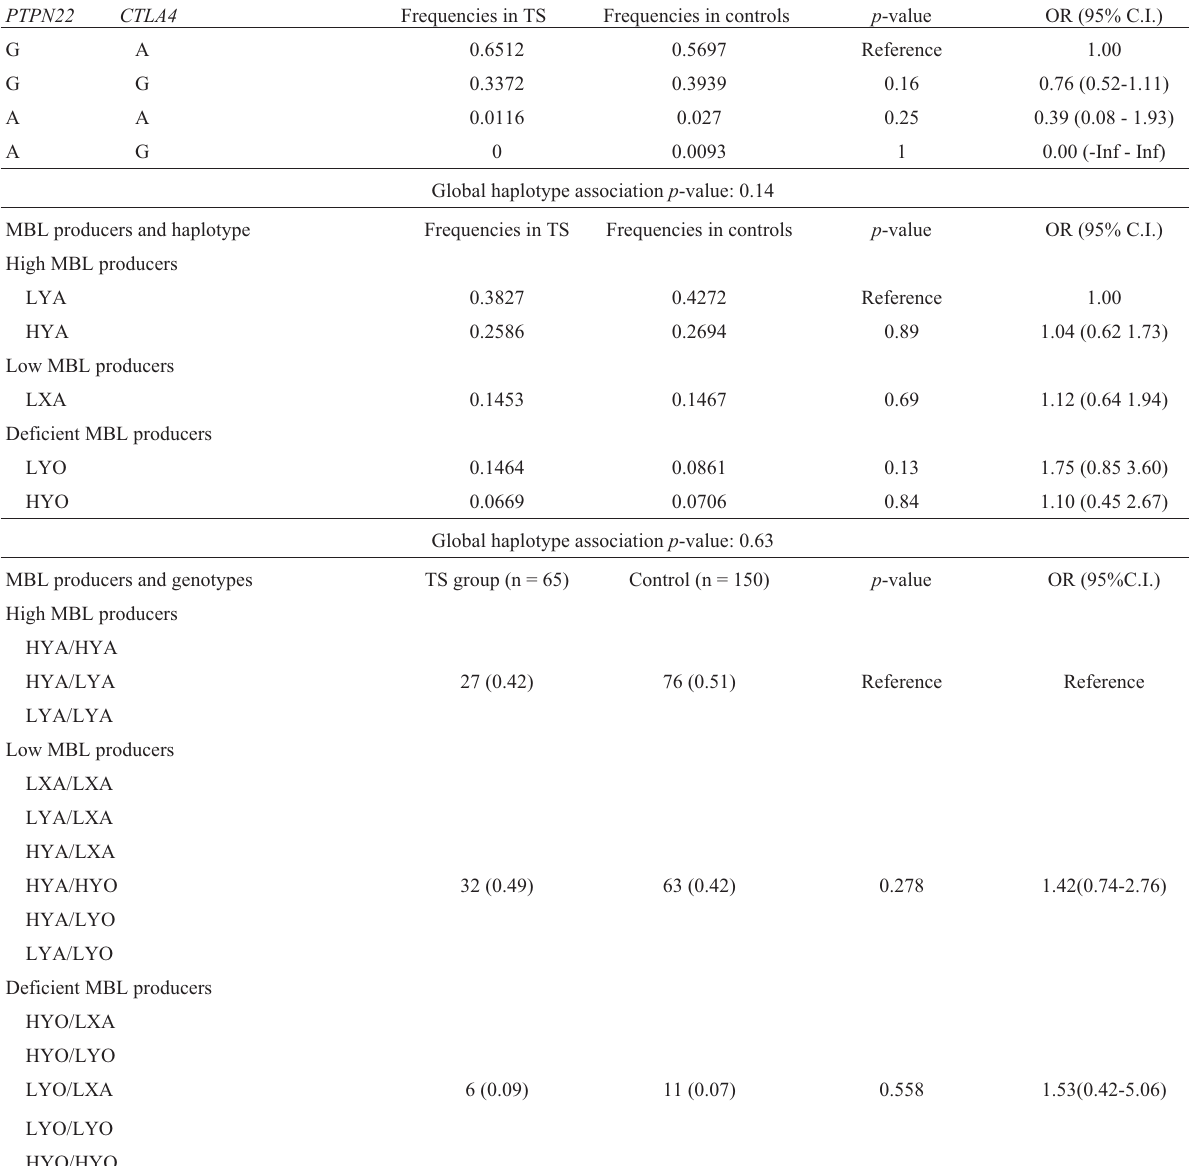
Table 5 - Analyses of combined alleles of PTPN22 and CTLA4 genes, haplotypes and genotypes of -550 and -221 promoter region and exon 1 of MBL2 gene in TS patients and